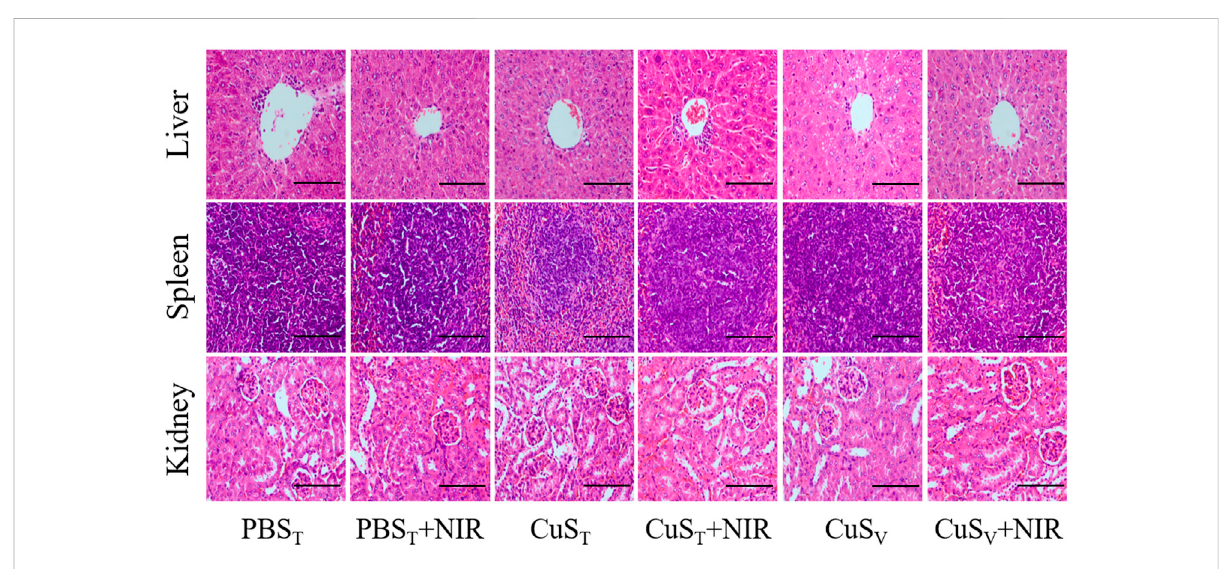
FIGURE 6 Pathological sections of the liver, spleen, and kidney in the photothermal experiment on H22 hepatoma-bearing mice (×400). Scale bars represent 100 μ